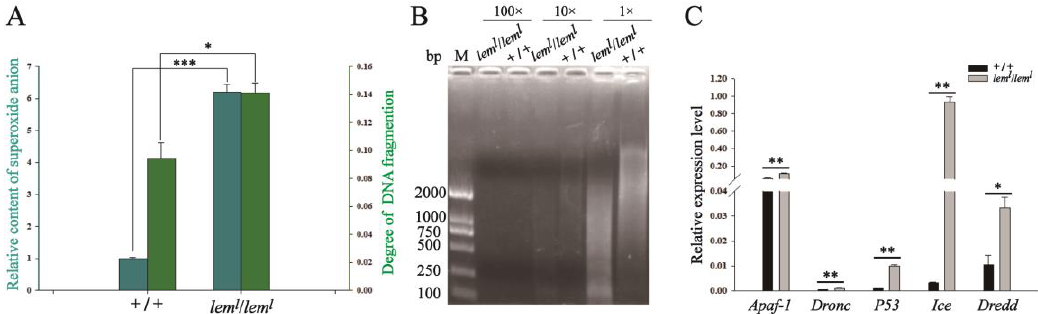
Figure 4. Increase in O 2 − led to DNA fragmentation and started the apoptotic system in lem l homozygotes. ( A ) The content of O 2 − (represented by dark green columns) and the proportion of somatic DNA fragmentation (represented by light green columns) increased in lem l . ( B ) The gel electrophoresis detection of lem l somatic cell DNA fragmentation. 1 × : undiluted sample, 10 × : diluted 10 times, 100 × : diluted 100 times. ( C ) The expression level of pro-apoptotic gene increased in lem l . All silkworm body materials were from second-instar lem l homozygous mutants. The accession numbers of genes and proteins involved in the figure are shown in Table 2. Data are mean values ± S.E.M ( n = 3). Error bars represent mean ± SD; * p < 0.05; ** p < 0.01; *** p < 0.001.